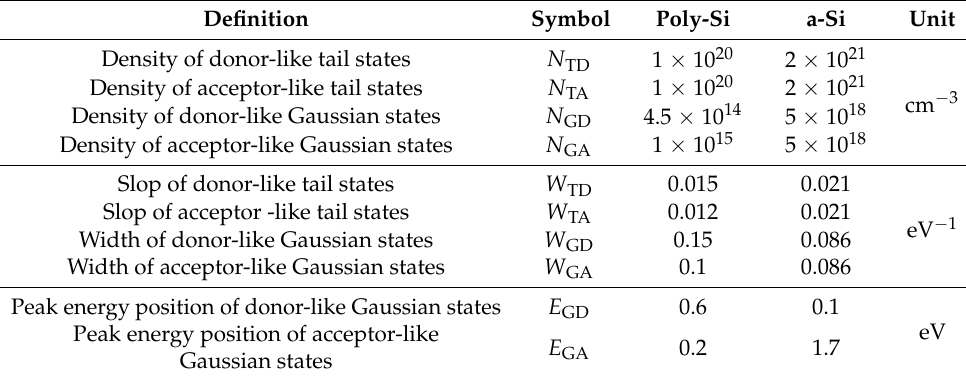
Table 2. Density of states (DOS) parameters of poly-Si and amorphous silicon (a-Si) [37].